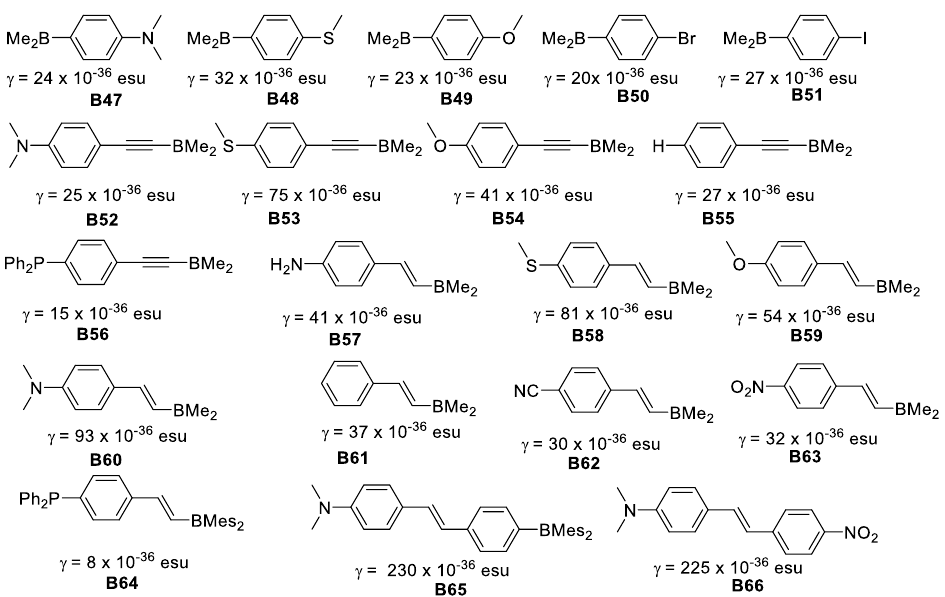
Figure 24. Second order hyperpolarizabilities for unsymmetric dimesitylboranes and NO 2 analogous.